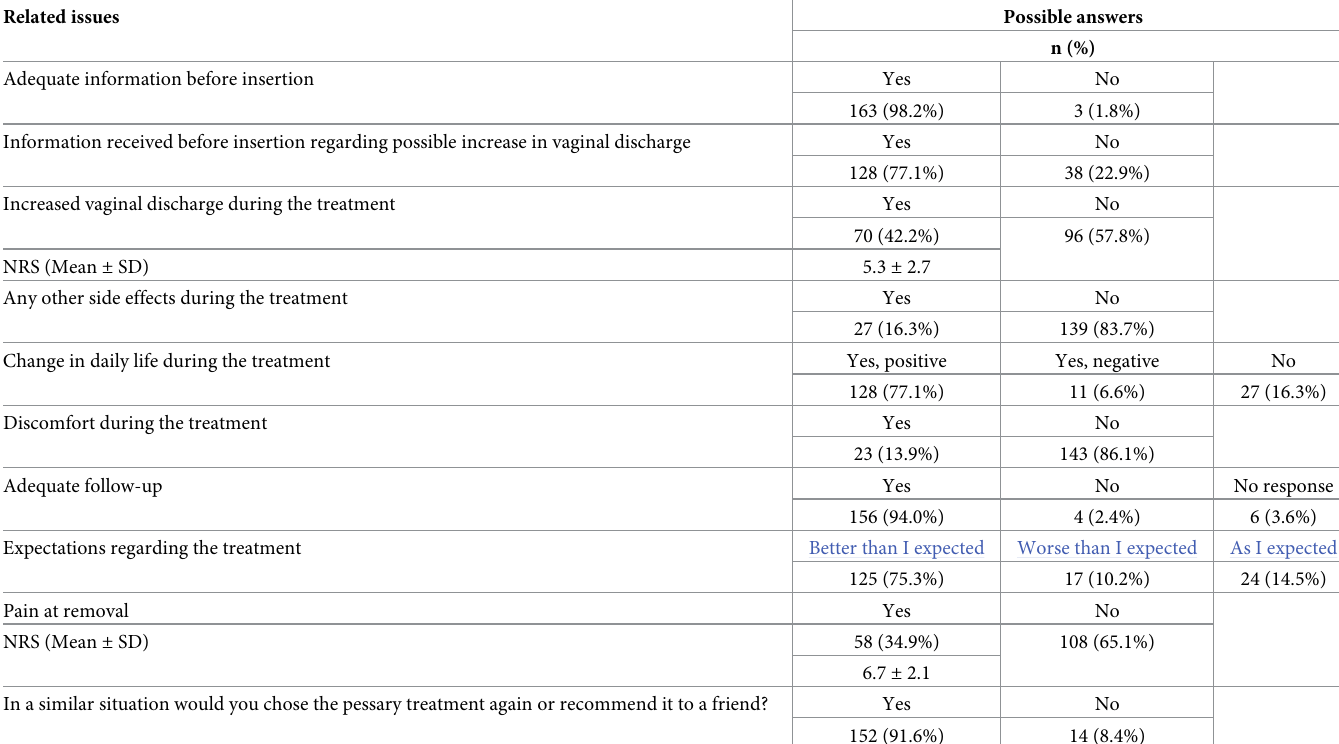
Table 2. Results of the questionnaire investigating maternal views and experiences before, during and after treatment with cervical pessary (n = 166).